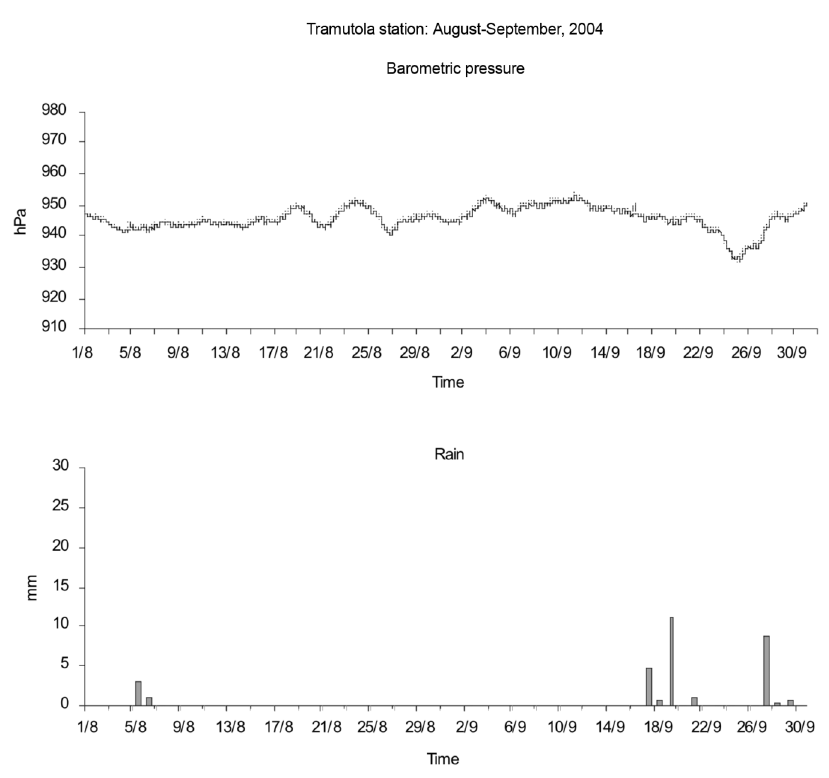
Fig. 5. Air pressure and rain recorded at the Tramutola station: August-September 2004. No strong barometric pressure variations and rain events occurred during the seismic sequence starting on September